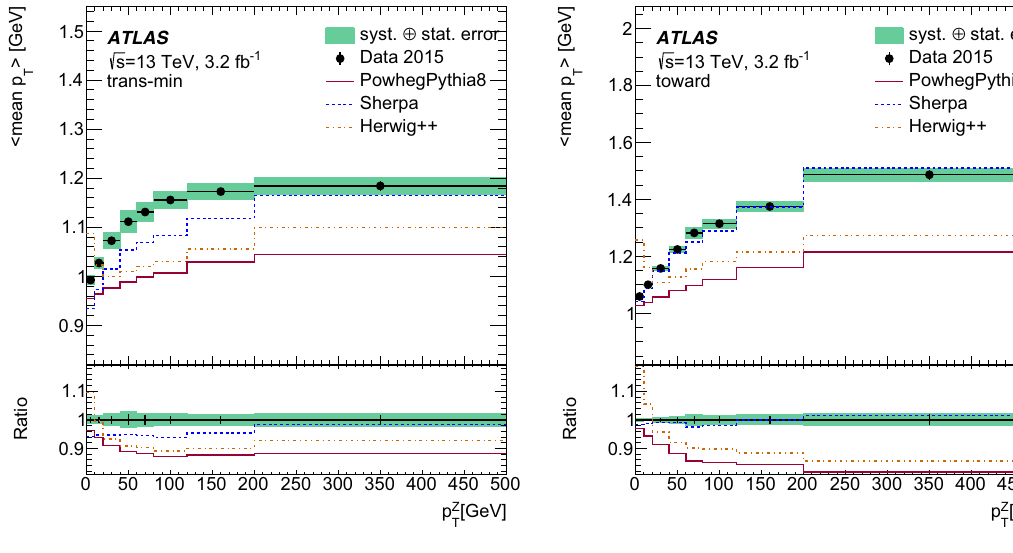
Fig. 10 Comparison of measured arithmetic means of mean p T as functionsof p Z forthetrans-min(left)andtowards(right)regionsinclu- T sively, and in regions of T ⊥ . Predictions of Powheg + Pythia , Sherpa ,